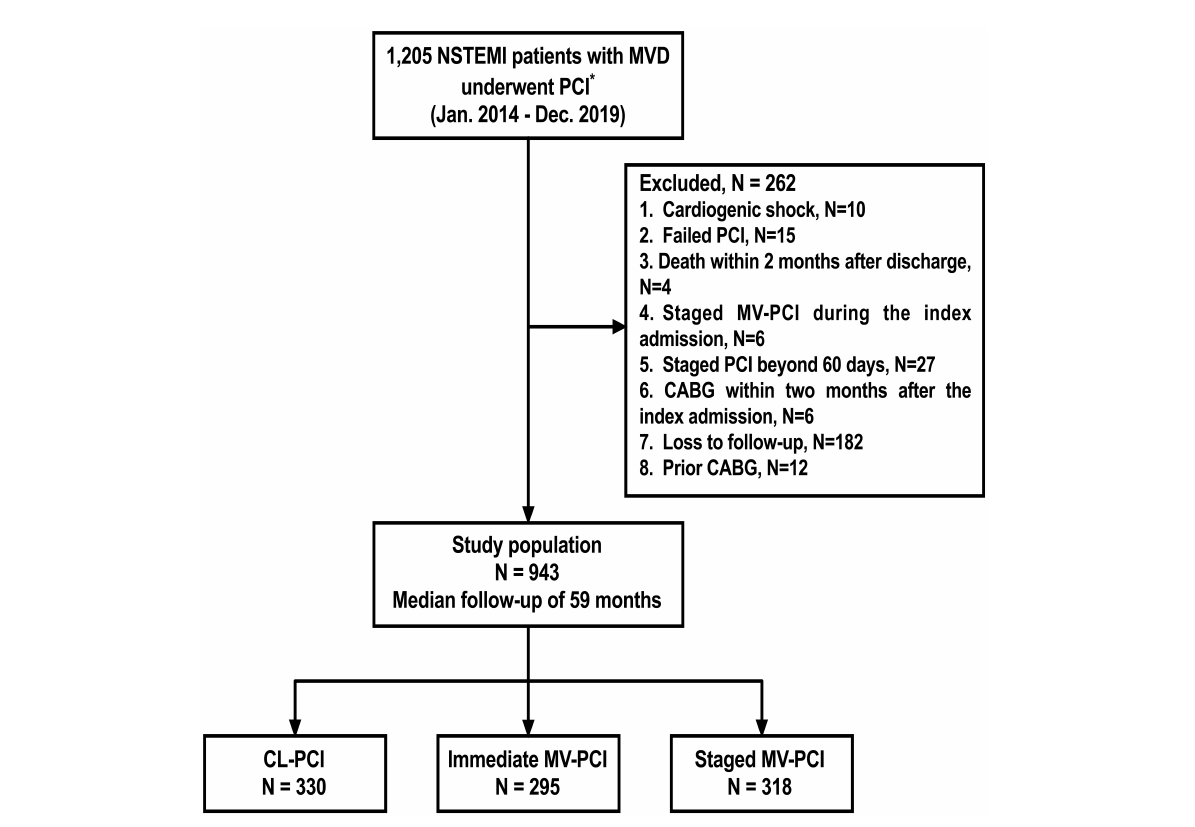
FIGURE1 Study flowchart. *All patients could tolerate dual anti-platelet therapy for at least 12 months. NSTEMI, non–ST-segment–elevation myocardial infarction; MVD, multivessel disease; PCI, percutaneous coronary intervention; MV-PCI, multivessel percutaneous coronary intervention; CL-PCI, culprit-only percutaneous coronary intervention; CABG, coronary artery bypass grafting.